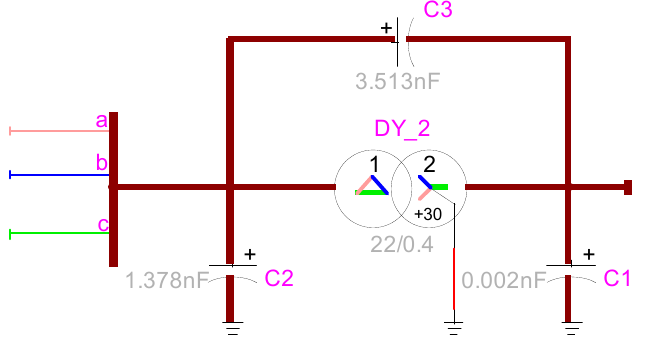
∆ Y-connection model of the transformer with measured Figure 8. ∆Y -connection model of the transformer with measured capacitances. Figure 8. Figure 8. ∆Y -connection model of the transformer with measured capacitances. Figure 8. ∆Y -connection model of the transformer with measured capacitances.